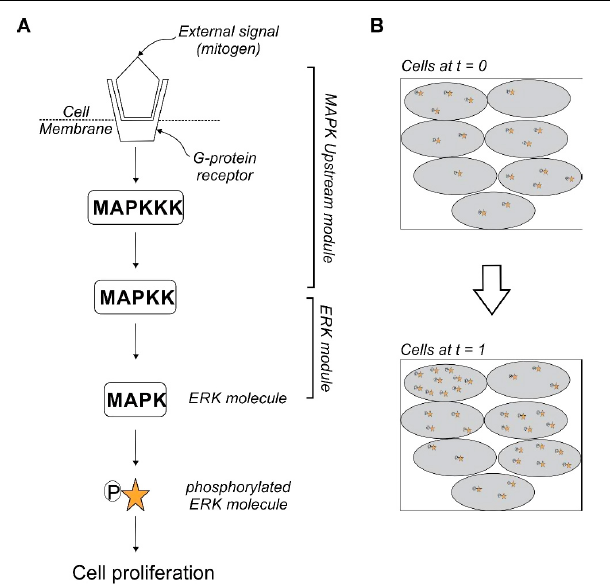
FIGURE 7 | Heterogeneity of MAPK signaling (A) depicts the phosphorylation of the primary MAPK molecule ERK (extracellular-signal-regulated kinase) by a MAPKK (mitogen-activated protein kinase kinase). The activation of the core ERK module relays the stimulus to the nucleus for cell proliferation. Factors like ligand availability at the surface and reaction times of other reactions before the phosphorylation of ERK are the upstream module which, effect the core ERK reaction. (B) Cartoon of a time-lapse snapshot of cells shows that the concentration of activated ERK at t = 1 is dependent on the number of activated ERK molecules at t = 0. There is a heterogeneity in the relay of stimulus across cells in the same sub-population. This distributes the response to external stimulus within clonal